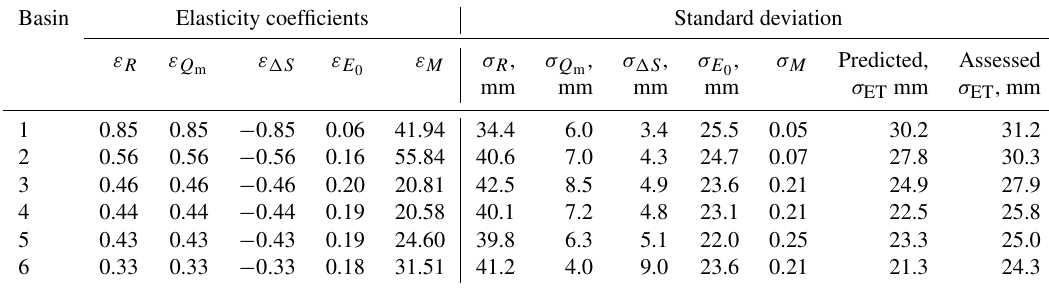
Table 2. The elasticity coefficients of ET for five variables and the standard deviation of each variable for the six basins. Basin Elasticity coefficients Standard